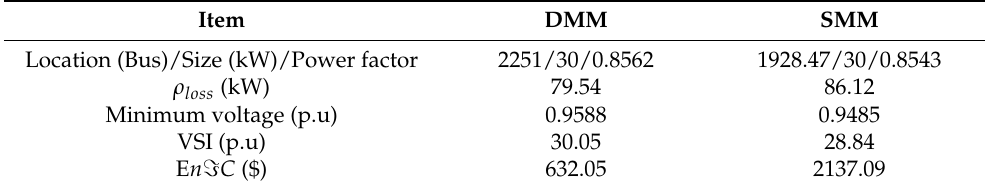
Table 6. Comparison of simulation results of 33-bus network based DMM and SMM. Item DMM SMM Location (Bus)/Size (kW)/Power